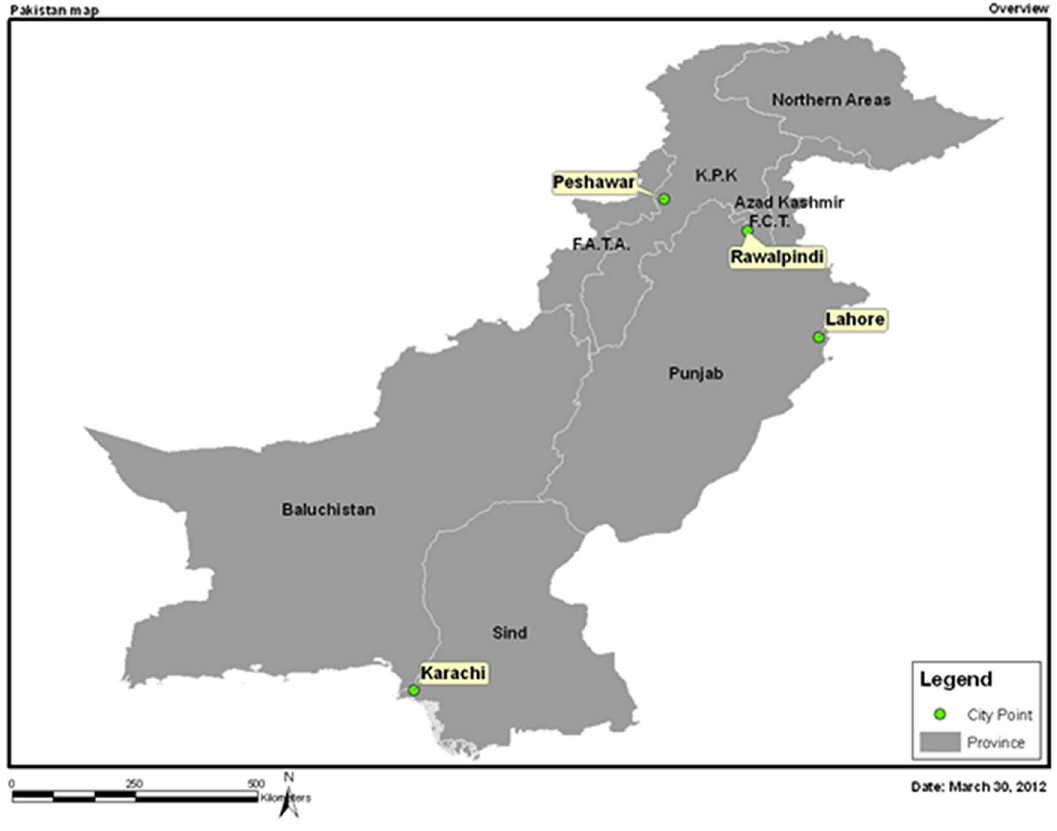
Figure 1. Geographic distribution of the five sentinel sites participating in rotavirus surveillance in Pakistan from 2006–2008.